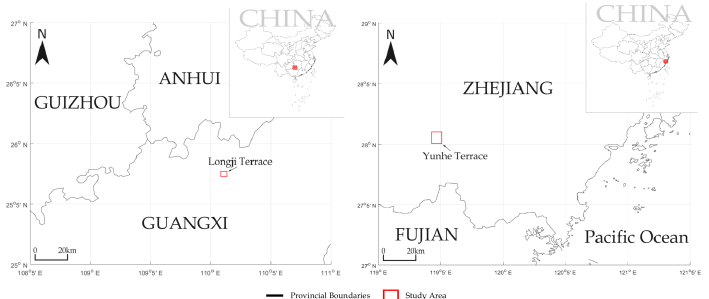
Figure 6. Location of Longji and Yunhe terraces. Longji terrace is located in Guangxi province, China (Longitude range: 110 ◦ 08 (cid:48) 65 (cid:48)(cid:48) E to 110 ◦ 14 (cid:48) 15 (cid:48)(cid:48) E; Latitude range: 25 ◦ 72 (cid:48) 51 (cid:48)(cid:48) N to 2 ◦ 76 (cid:48) 77 (cid:48)(cid:48) N.). Yunhe terrace is located in Zhejiang province, China (Longitude range: 11 ◦ 42 (cid:48) 73 (cid:48)(cid:48) E to 119 ◦ 51 (cid:48) 11 (cid:48)(cid:48) E; Latitude range: 28 ◦ 00 (cid:48) 58 (cid:48)(cid:48) N to 28 ◦ 10 (cid:48) 01 (cid:48)(cid:48)